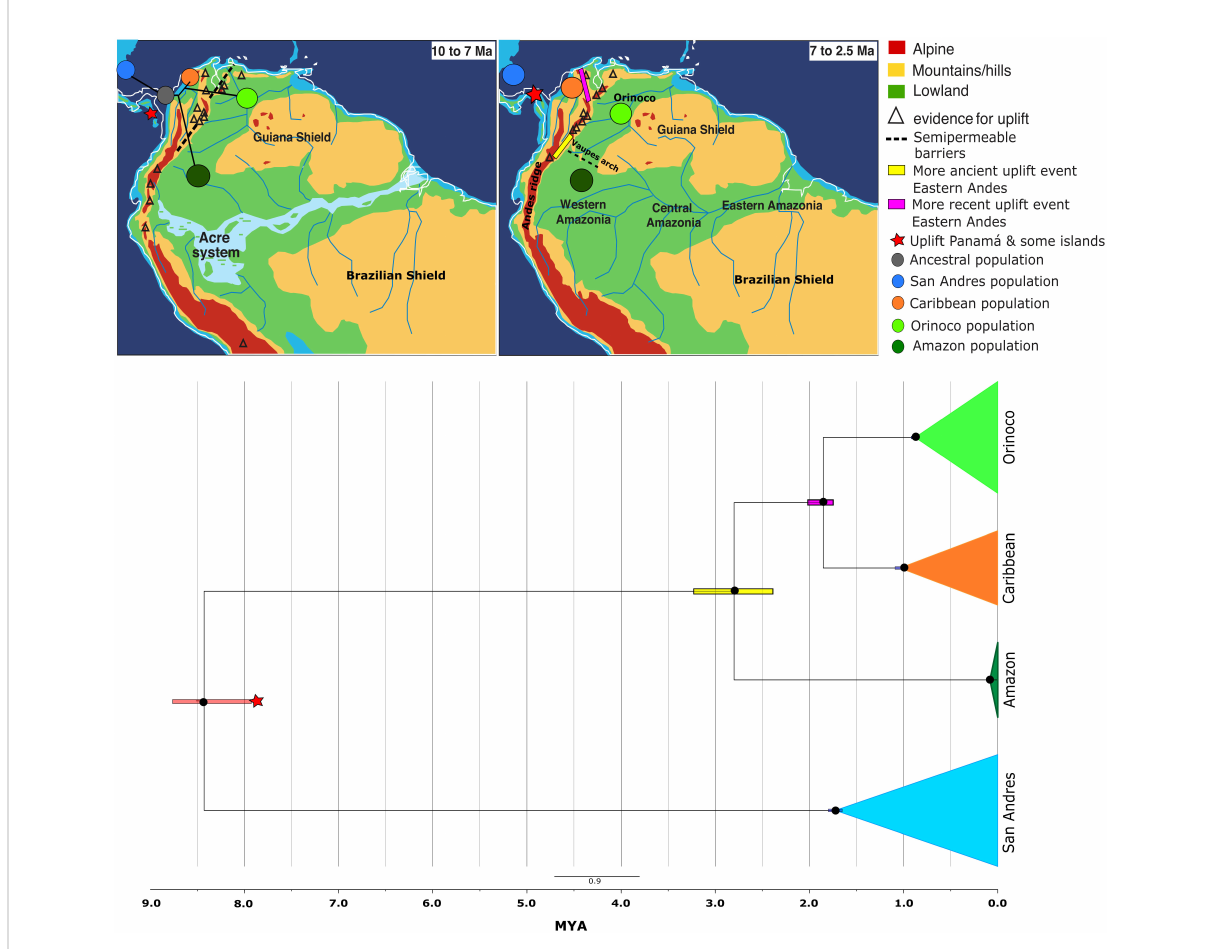
FIGURE 2 Bayesian time-calibrated Maximum Clade Credibility Tree inferred in BEAST v1.8.2, showing the phylogenetic reconstruction and ancestral relationship of Kinosternon scorpioides from insular (San Andre ́ s) and continental (Caribbean, Orinoco and Amazon) Colombia, using RADseqs of 3-4 individuals per population with 35,507 SNPs containing <2% of missing data (except for Amazon, with >= 98% of missing data), combined with 1,047 bp of R35 Intron, estimated under a GTR+G model of molecular evolution. The observed times are median heights into 95% credibility intervals, calibrated from a nuclear DNA substitution rate of 2.7x10-4 mutations per site per million year (Lourenc ̧ o et al., 2013). Black circles indicate nodes with supports ≥ 0.95 of posterior probability. Geographic map [modi fi ed from Hoorn et al. (2010)] showing all possible orogenic and biogeographical events occurring during 10 - 2.5 million years ago in the Neotropics, coinciding with the diversi fi cation of K. scorpioides in